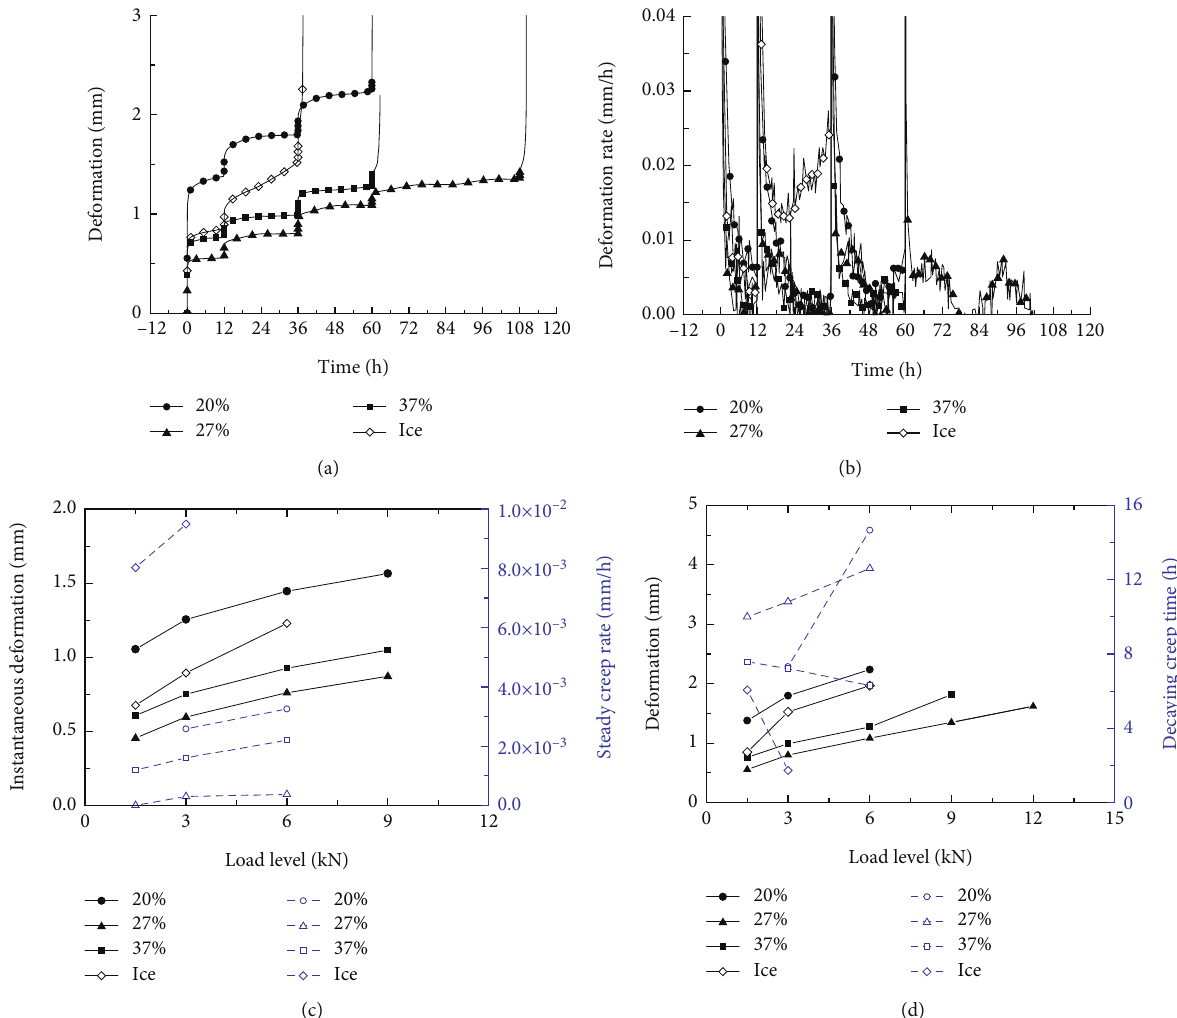
Figure 9: Creep parameters of interfaces between pile and frozen soil with di ff erent moisture